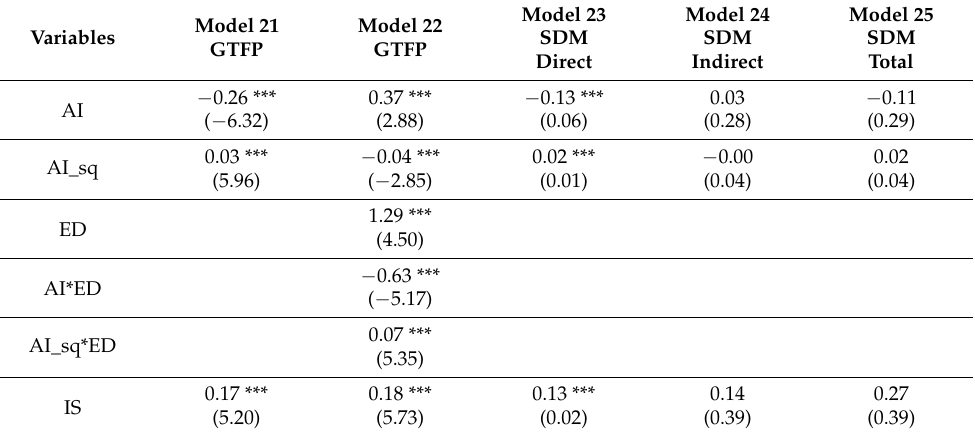
Table 9. Robustness test